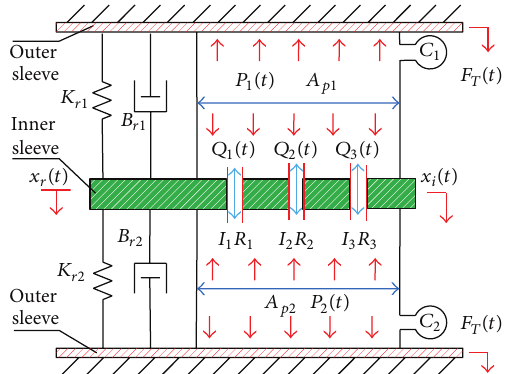
Figure 8: Fluid system model for an HDB with three nonidentical inertia